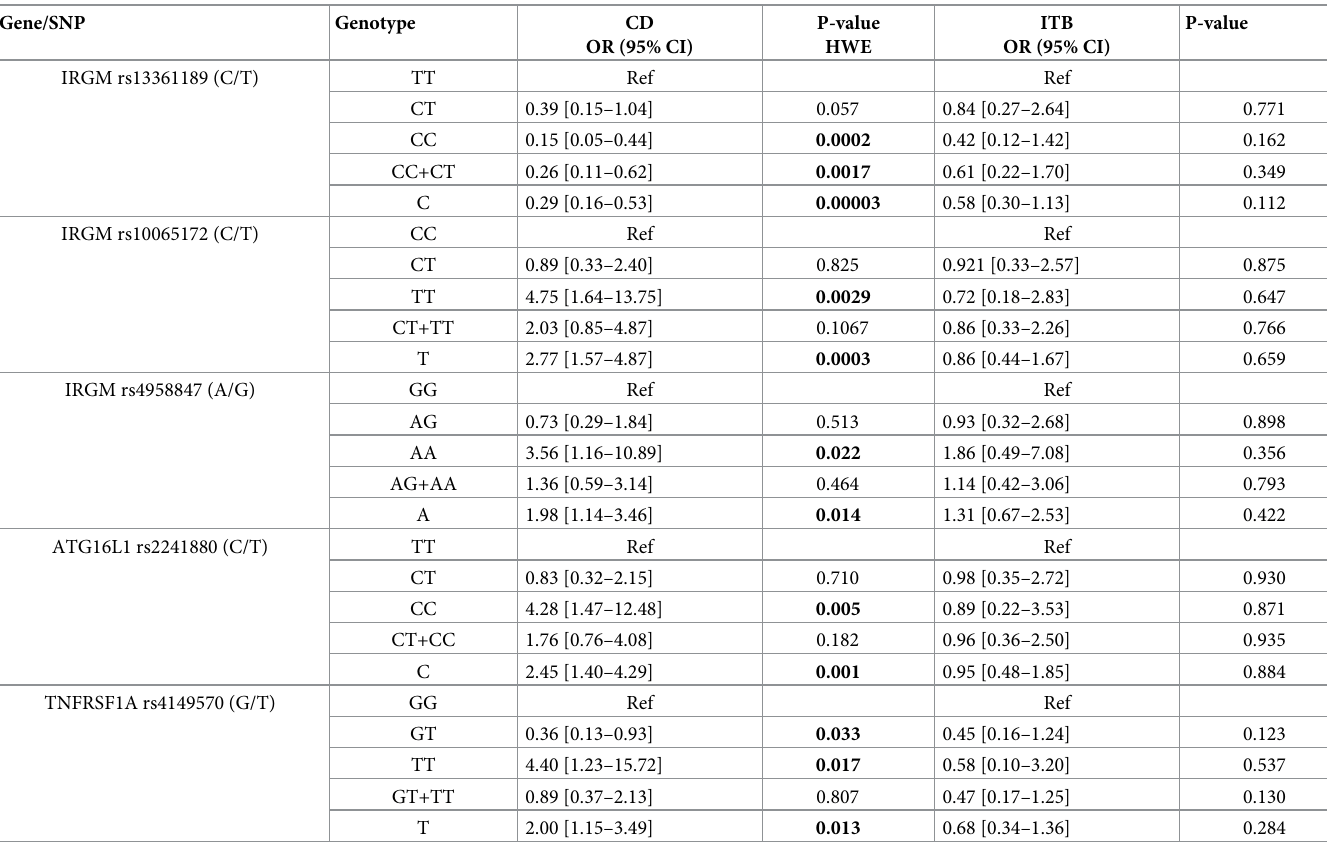
Table 4. Association of risk allele and genotype of single nucleotide polymorphisms with CD and ITB cases as compared to healthy